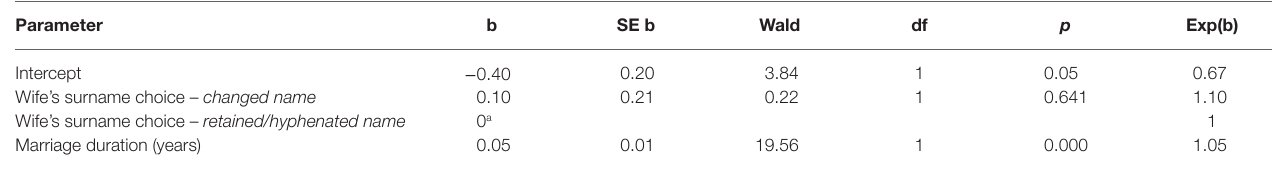
TABLE 4 | Negative binomial regression, DV = duration of marriage in years ( n = 107). Parameter b SE b Intercept